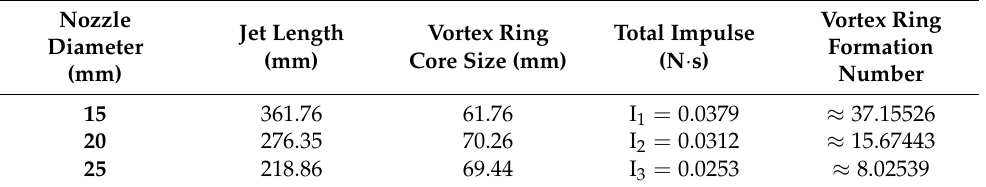
Table 2. Jet length, vortex ring core diameter, total impulse, and vortex ring formation number at different nozzle diameters.